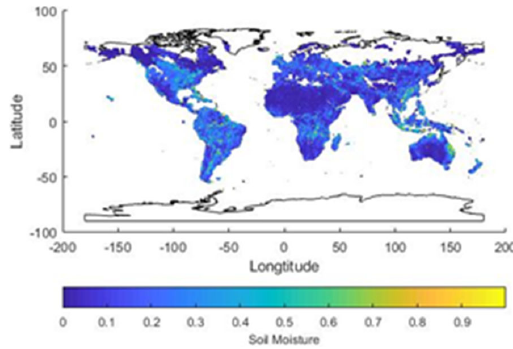
Figure 1. SMOSL3 monthly data from January to March 2017